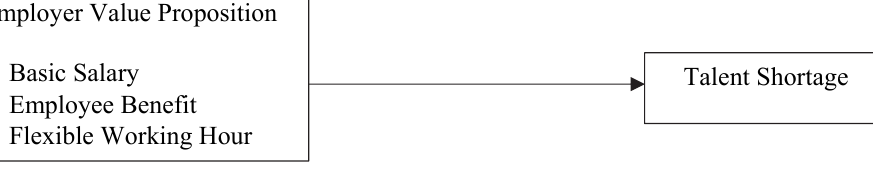
Fig. 1. The proposed study of the